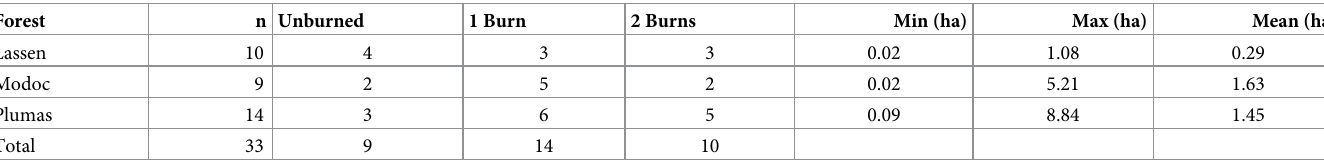
Table 1. Number of aspen stands by disturbance type, and range of stand